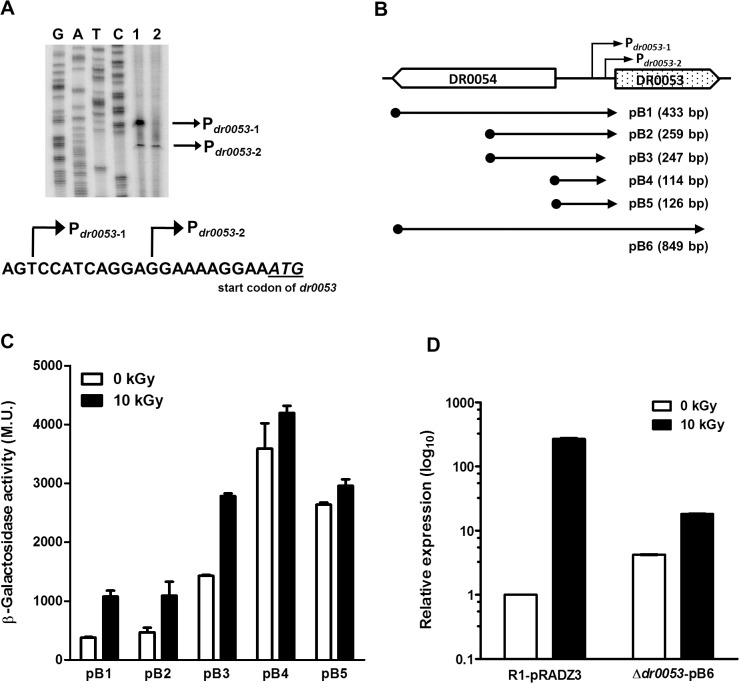
Promoter analysis of dr0053.(A) Primer extension assays were performed to map the transcriptional start site of dr0053. Total RNAs were extracted from 10 kGy irradiated (lane 1) and non-irradiated (lane 2) D. radiodurans cells after recovery for 1 h. RNA aliquots (30 μg) were subjected to primer extension analysis, and a sequence ladder was generated using the same primer. The two putative transcriptional start sites are indicated by arrows. (B) Schematic diagram of the dr0053 region in the wild-type genome. The coding regions are marked by arrowhead boxes displaying their orientation. The upstream regions of dr0053 cloned in the pRADZ3 plasmid containing the lacZ reporter are aligned below the diagram and are shown next to the plasmid name. The number in the brackets indicates the inserted fragment length. (C) β-galactosidase activities of the R1 cells harboring pB1 to pB5 promoter clones were measured after exposure to γ-radiation followed by 1 h of PIR. The data represent the means and standard deviations from three independent experiments consisting of duplicate samples. (D) The wild-type strains harboring pRADZ3 (R1-pRADZ3) and the dr0053 mutant strains harboring pB6 (Δdr0053-pB6) were exposed to γ-radiation and were allowed to recover for 1 h. After total RNA isolation, qRT-PCR analysis was performed to determine dr0053 transcript levels. Relative expression values were determined by defining the mRNA levels from non-treated R1 cultures as 1. Error bars indicate the standard deviations from three independent experiments conducted in duplicate.